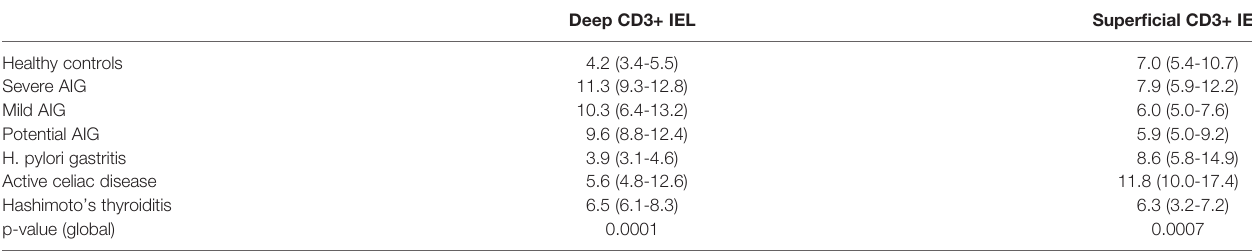
TABLE 1 | Deep and super fi cial CD3+ intraepithelial lymphocyte (IEL) counts (median and interquartile range) in the seven study groups.